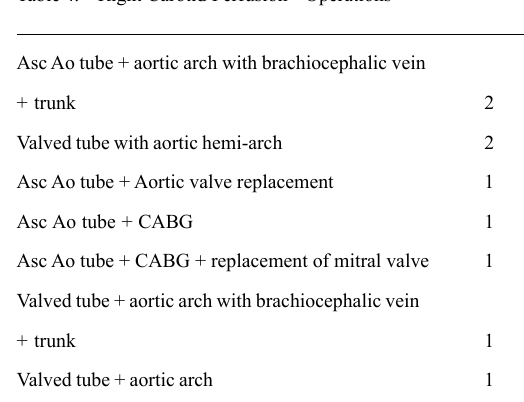
Table 4. Right Carotid Perfusion -